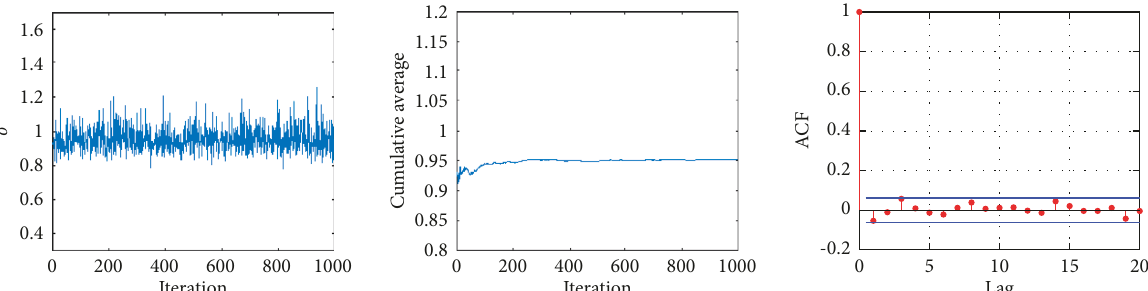
Figure 4: Graphical diagnoses of Metropolis–Hasting algorithm. (a) A sequence of 1000 generations from posterior density functions of σ ; (b) cumulative average graph of σ sequence; (c) autocorrelation graph of σ